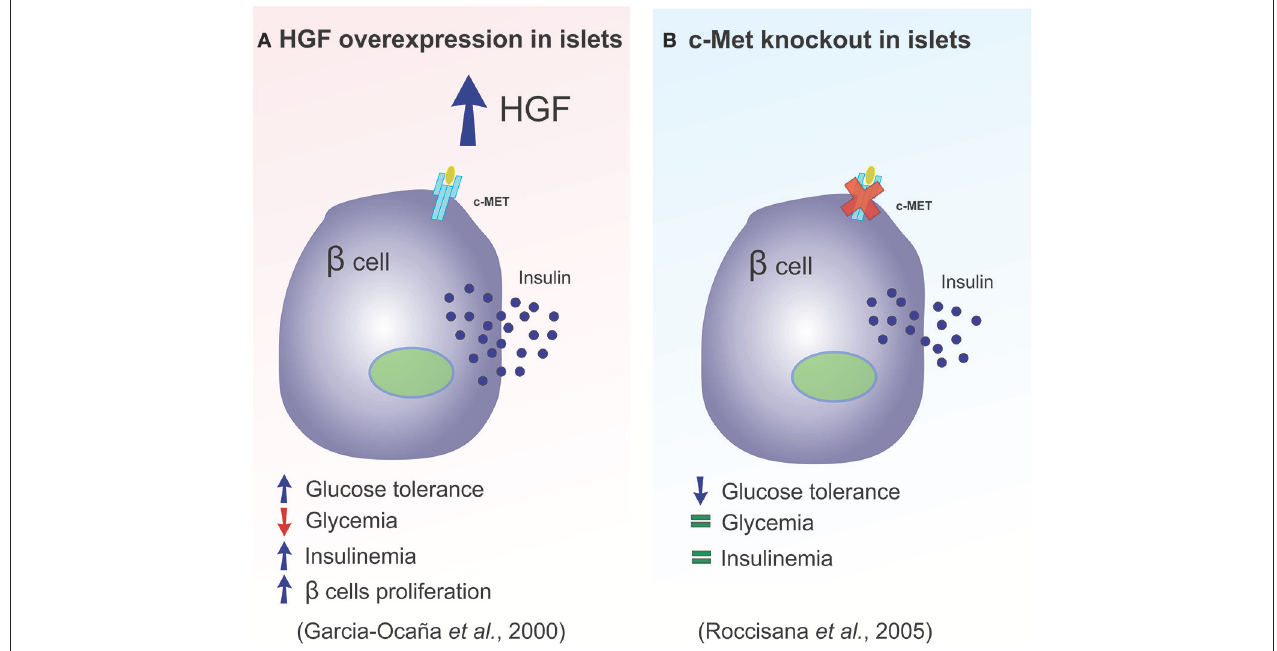
FIGURE 3 | HGF plays a key role in pancreatic β -cell homeostasis. (A,B) Diagram illustrating the main differences observed between the overexpression of HGF and the absence of the c-Met receptor in pancreatic β -cells.